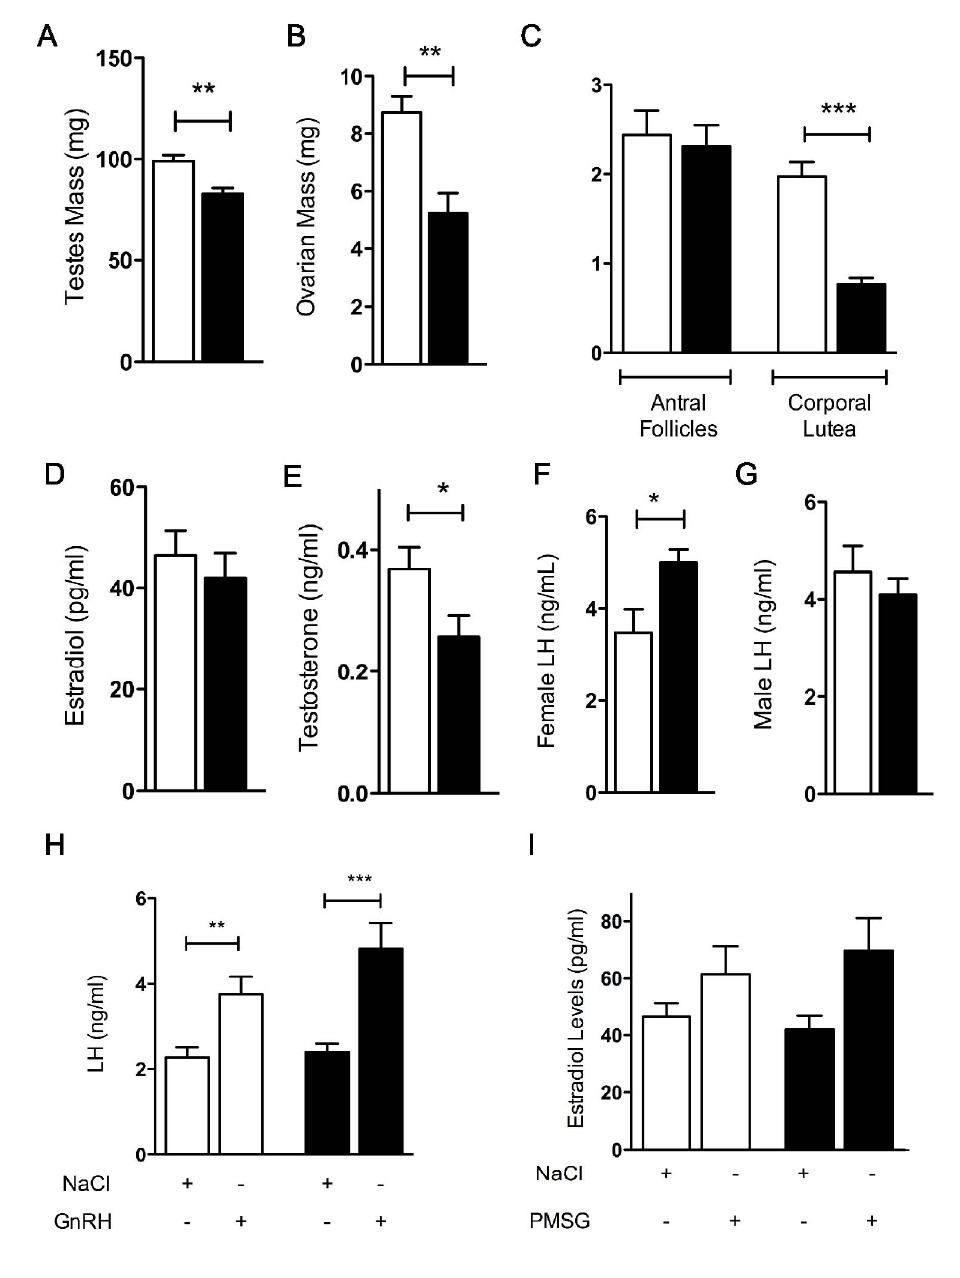
Figure 5. nes-Cre ; Dmxl2 –/wt mice displayed a partial gonadotropin deficiency. (A and B) Weights of testes and ovaries were low in nes- Cre ; Dmxl2 –/wt mice. (C) Histological analysis of ovaries showed a normal number of antral follicles but very few corpora lutea in female nes-Cre ; Dmxl2 –/wt mice. (D) Estradiol concentrations were normal in female nes-Cre ; Dmxl2 –/wt mice. (E) Plasma testosterone concentration was low in male nes-Cre ; Dmxl2 –/wt mice. (F) Plasma LH concentrations were moderately high in female nes-Cre ; Dmxl2 –/wt mice. (G) Despite their lower testosterone concentrations, male nes-Cre ; Dmxl2 –/wt mice had normal plasma LH concentrations. (H) The GnRH-induced increase in LH concentration was normal in nes-Cre ; Dmxl2 –/wt mice. (I) The administration of PMSG to young mice induced a normal increase in estradiol concentration in nes-Cre ; Dmxl2 –/wt mice, similar to that observed intheir WTlittermates(asterisks indicate significant differences: * p , 0.05,** p , 0.001; *** p , 0.0001). Error bars: SEM. P, postnatal day. White bars, Dmxl2 lox/wt ; black bars, nes-Cre ; Dmxl2 –/wt . Numerical data used to generate these graphs may be found in Table